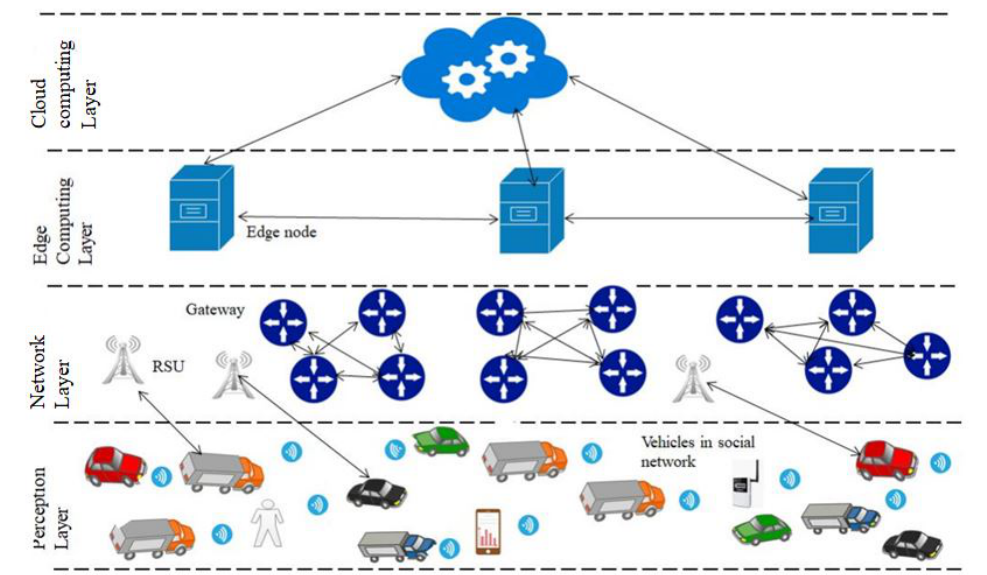
Figure 1. Layered Architecture of Social Internet of Vehicle